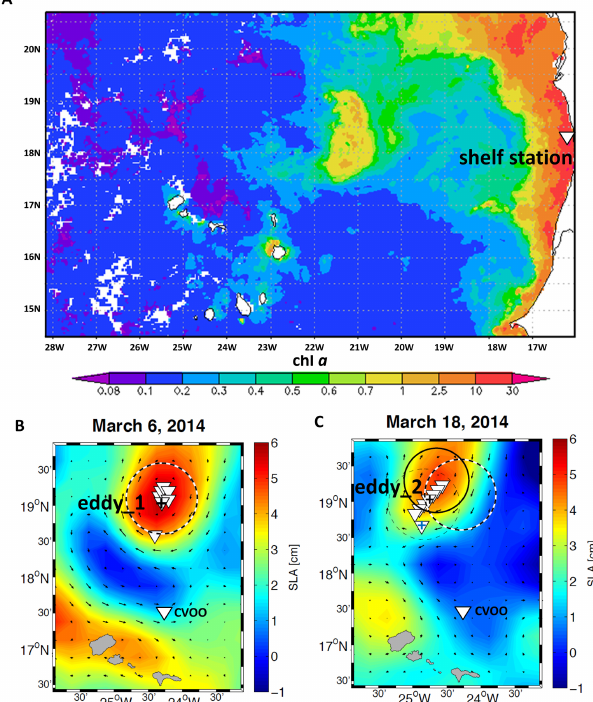
Figure 1. (a) MODIS-Aqua 4km monthly mean chl a distribution in the ETNA (mgm − 3 ) in November 2013. Markedly increased chl a concentrations are associated with the low-oxygen ACME, located between 21c and 22 ◦ W and 17.5 and 19 ◦ N. Analyses and visualizations were produced with the Giovanni online data system, developed and maintained by the NASA GES DISC. Eddy location indicated by sea level anomaly (SLA) during the time of the two surveys: (b) first eddy observation; + denotes the eddy_1 station, (c) second eddy observation + denotes the eddy_2 station, an ad- ditional station was sampled at the eddy rim for C uptake measure- ments, indicated by the blue + . White triangle marks the sampling station for the potential source water of the eddy. The dashed circles indicate the location of the eddy during the R/V Islandia survey, the black circle indicates the eddy location during the R/V Meteor survey, and the dashed black line indicates the direction of eddy propagation. Sampling stations are shown with white